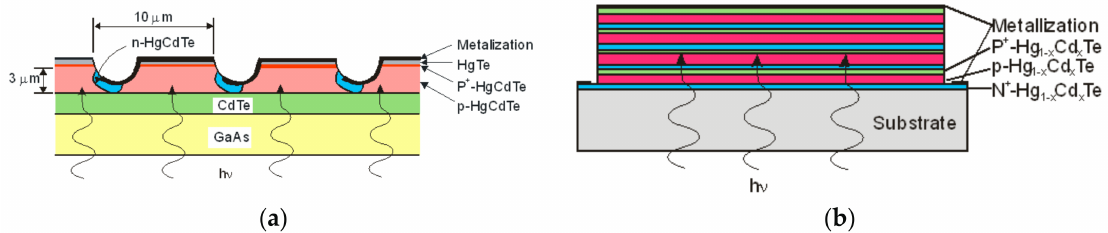
Figure 8. Backside illuminated multiple HgCdTe heterojunction devices: ( a ) junction’s planes perpendicular to the surface, and ( b ) 4-cells stacked multiple detector (after reference